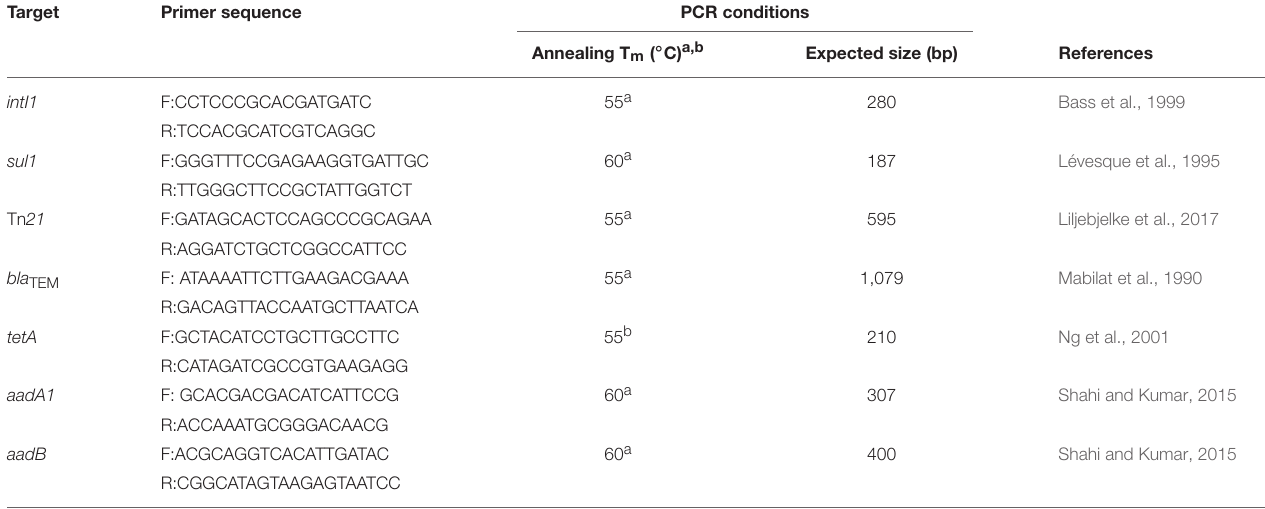
TABLE 3 | PCR primers. Target